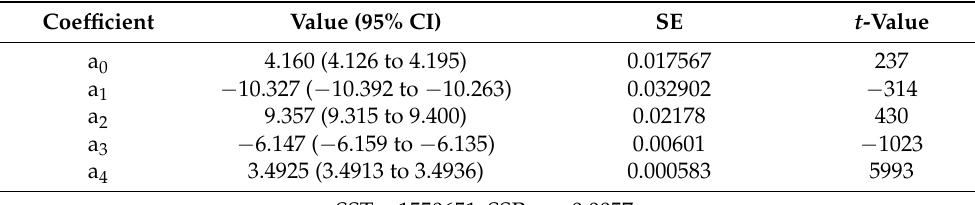
Table 6. Proposed model tested for the AD = AD( p ) series for n = 25. SST: Sum of Squares: Total; SSRes: Sum of Squares: Residuals; SSE = Sum of Squares